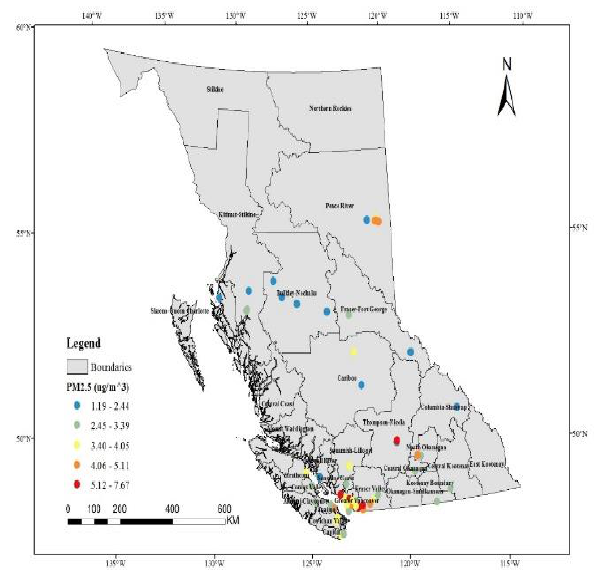
Fig. 4. Estimated PM 2.5 generated by the seasonal GWR model in spring (top); and averaged PM 2.5 concentrations from ground stations in spring (bottom).